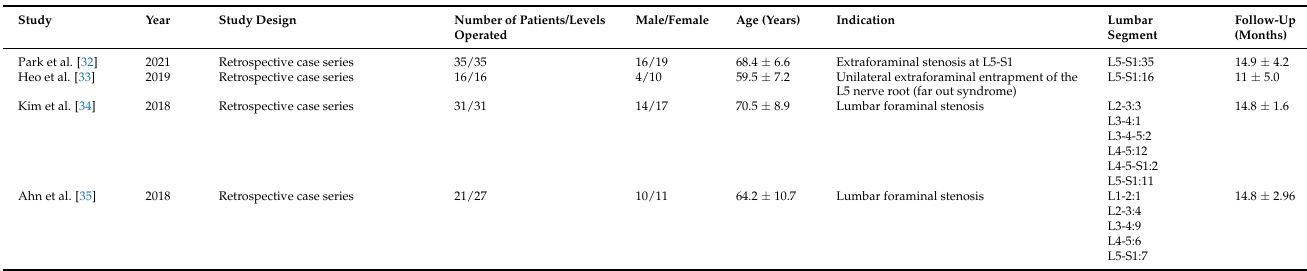
Table 3. Characteristics of the articles describing the paraspinal